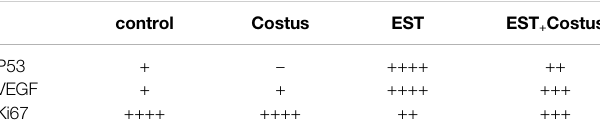
++ +++ Data are expressed as 10 fi elds of vision selected randomly and the positive cells were scored( − )negative,(+)faint,(++)mild,(+++)moderate,and(++++)severe.Where,EST, Ehrlich solid tumor; EST + Costus, treated Ehrlich solid tomor with